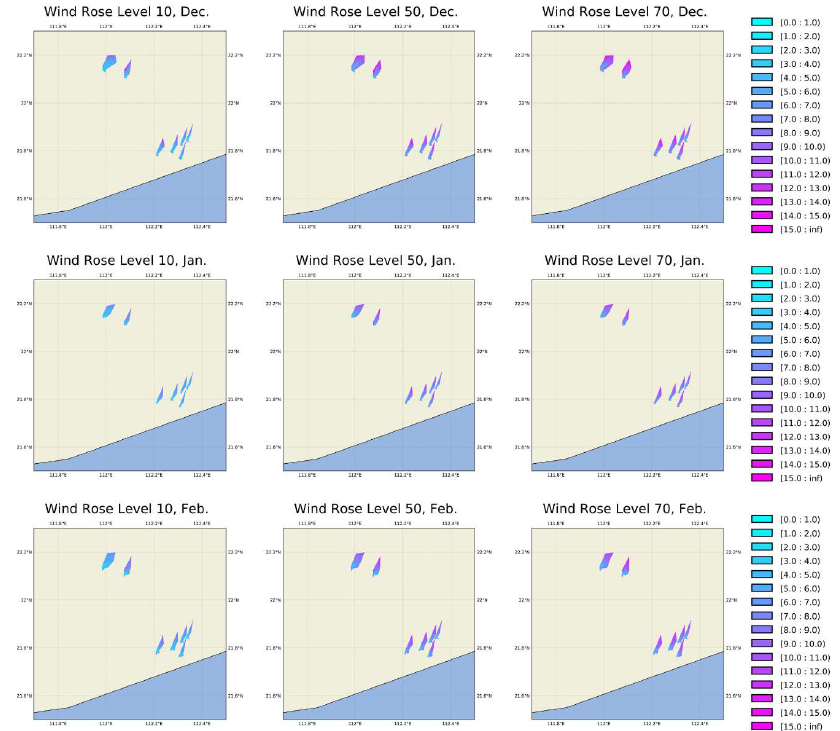
Figure A4. Wind rose of Test 2 results in the seven tower positions in winter (Dec., Jan., and Feb.)